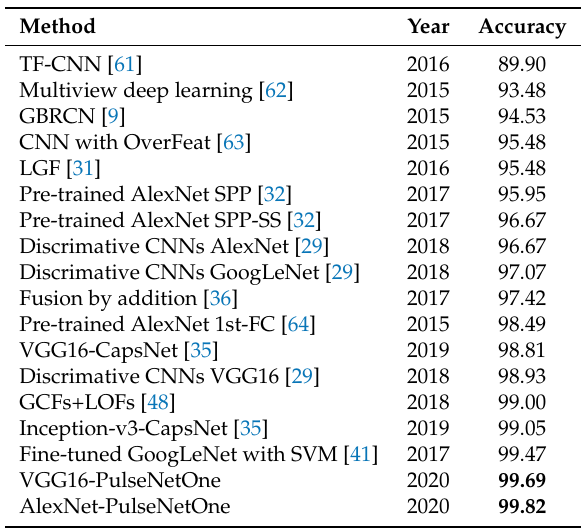
Figure 12. Barcharts for AlexNet and VGG16, illustrating the difference between the theoretical, CPU and GPU efficiency with respect to their computational speed and energy consumed on the UC Merced dataset. Table 13. A comparison between state-of-the-art and PulseNetOne results on the UCM dataset. The entries in bold show the method with the best classification for the